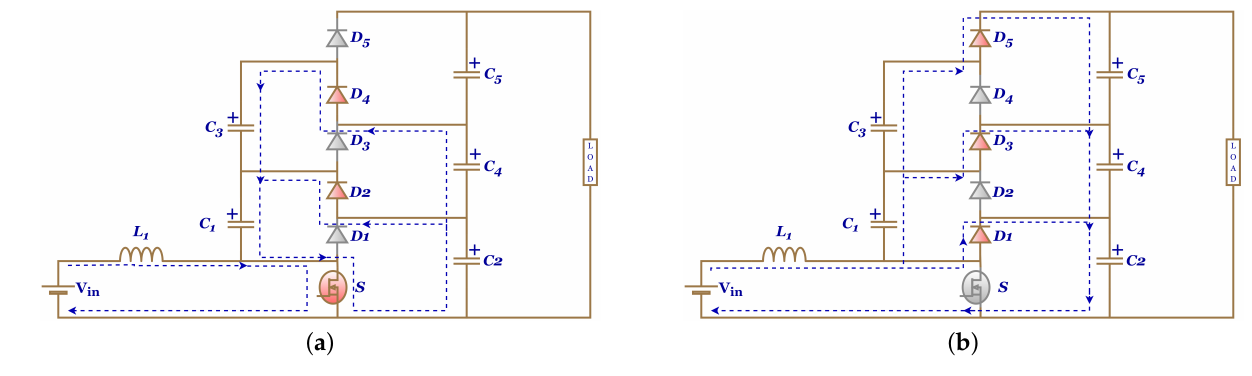
Figure 5. TBC operation: ( a ) S closed and ( b ) S open.